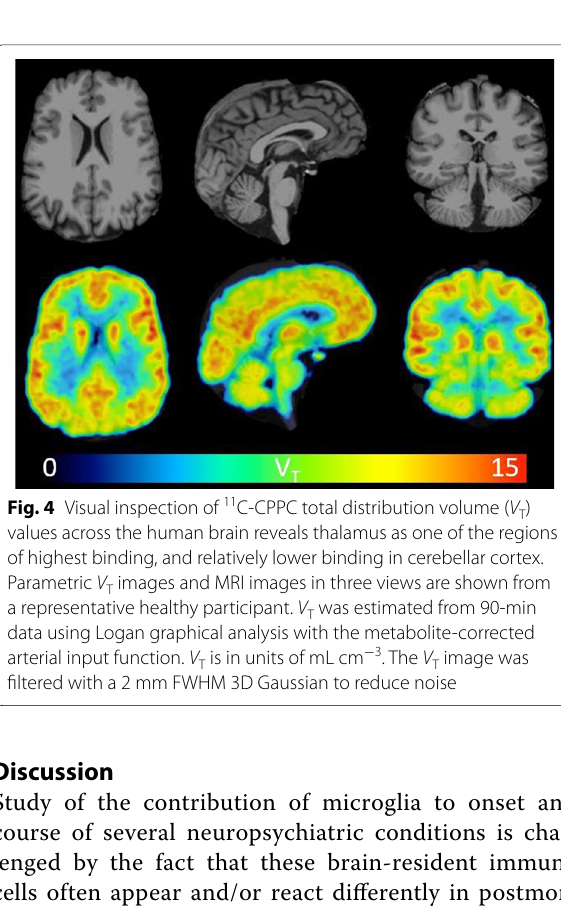
Table 1 Kinetic parameters and total distribution volume ( V along with V values estimated using two-tissue compartment model (2TCM), and Logan analysis for 11 C-CPPC PET imaging in humans T